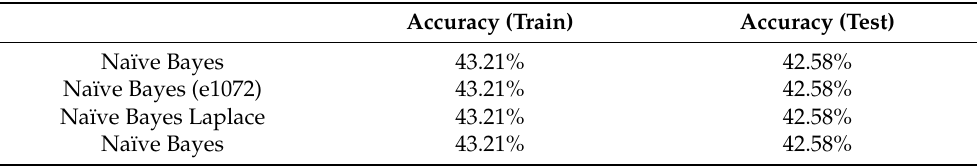
Table 3. Techniques’ accuracy.